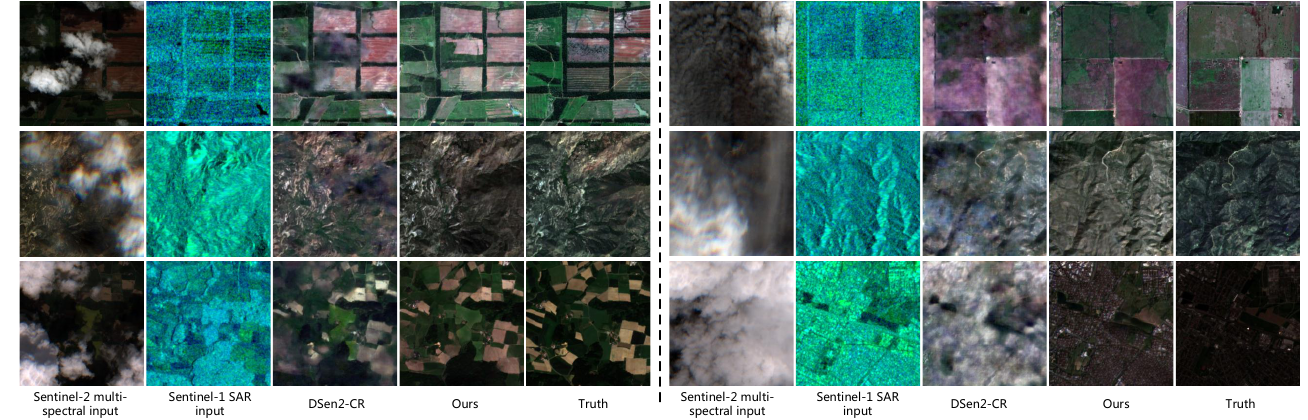
Figure 8. Reconstruction visualization results for removing multispectral cloud images on the SEN12MS-CR dataset with DSen2-CR [29] and ours. The Sentinel-2 satellite data contain 13 spectral bands, and the visualization images are rendered as an RGB composite using RGB bands. Sentinel-1 SAR satellite data consist of two bands that are mapped onto the green and blue channels to provide a visual representation. Please zoom in for